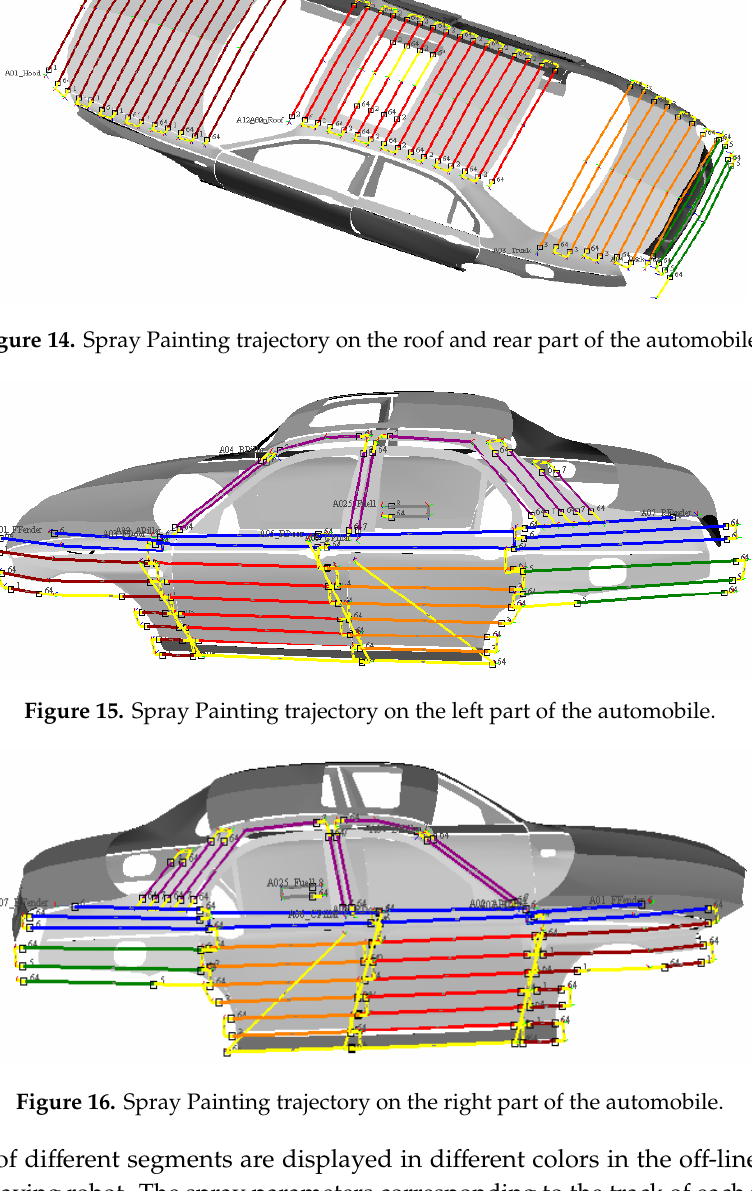
Table 1. Operating parameters of the spray painting trajectory on the roof and tail.